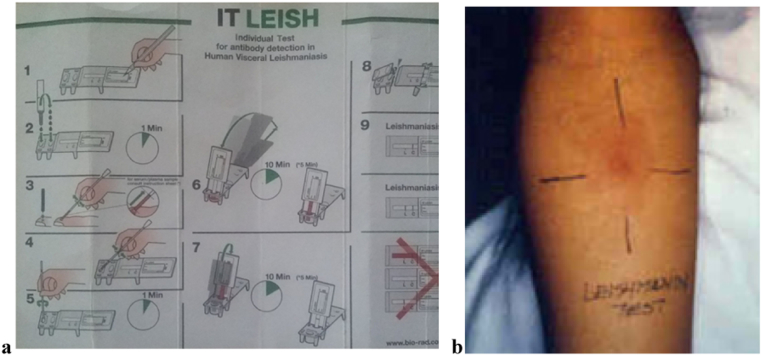
Serological tests for visceral Leishmaniasis, basic procedure a) ITleish (It-Leish brochure), and b) leishmanin skin test (http://www.who.int/leishmaniasis/surveillance/slides_manual/en/index11.html).